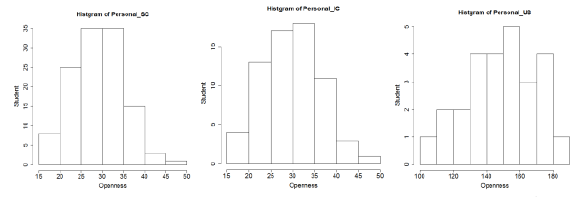
Figure 5. Histogram of Openness in each course (left: SDC, center: ITC, right: ODC)